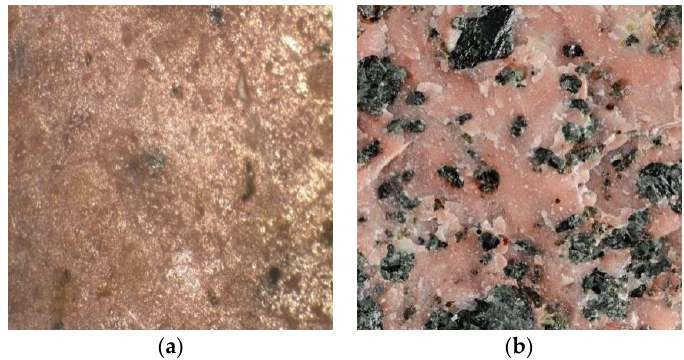
Figure 2. Surface Morphology (M × 35) of ( a ) Artificial Granite (60 wt % SSF/Poly (methyl methacrylate) (PMMA)/clay Halloysite nanotubules (HNTs)) compared to ( b ) natural Granite.